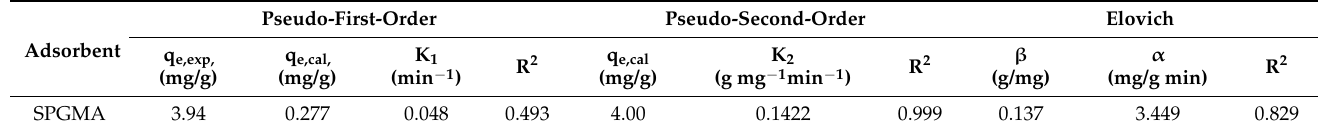
Figure 8. Simple Elovich sorption kinetic models for MB molecules ’ adsorption using SPGMA. Table 2. The adsorption parameters of the pseudo-first- and pseudo-second-order and the Elovich kinetic models.